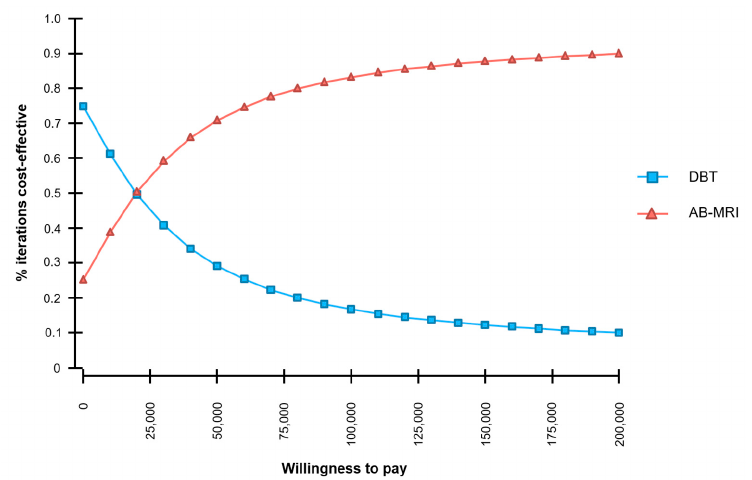
Figure 3. Cost ‐ effectiveness scatter plot. Incremental costs (US ‐ $) and effectiveness (quality ‐ ad ‐ justed life ‐ years, QALYs) when comparing AB ‐ MRI to DBT as determined in a Monte Carlo simu ‐ lation. The majority of the iterations fall below the willingness to pay (WTP) ‐ threshold of $100,000 per QALY. cost-effective.